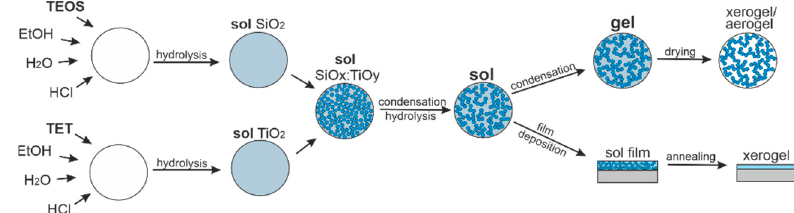
Figure 1. Scheme of sol–gel processes.